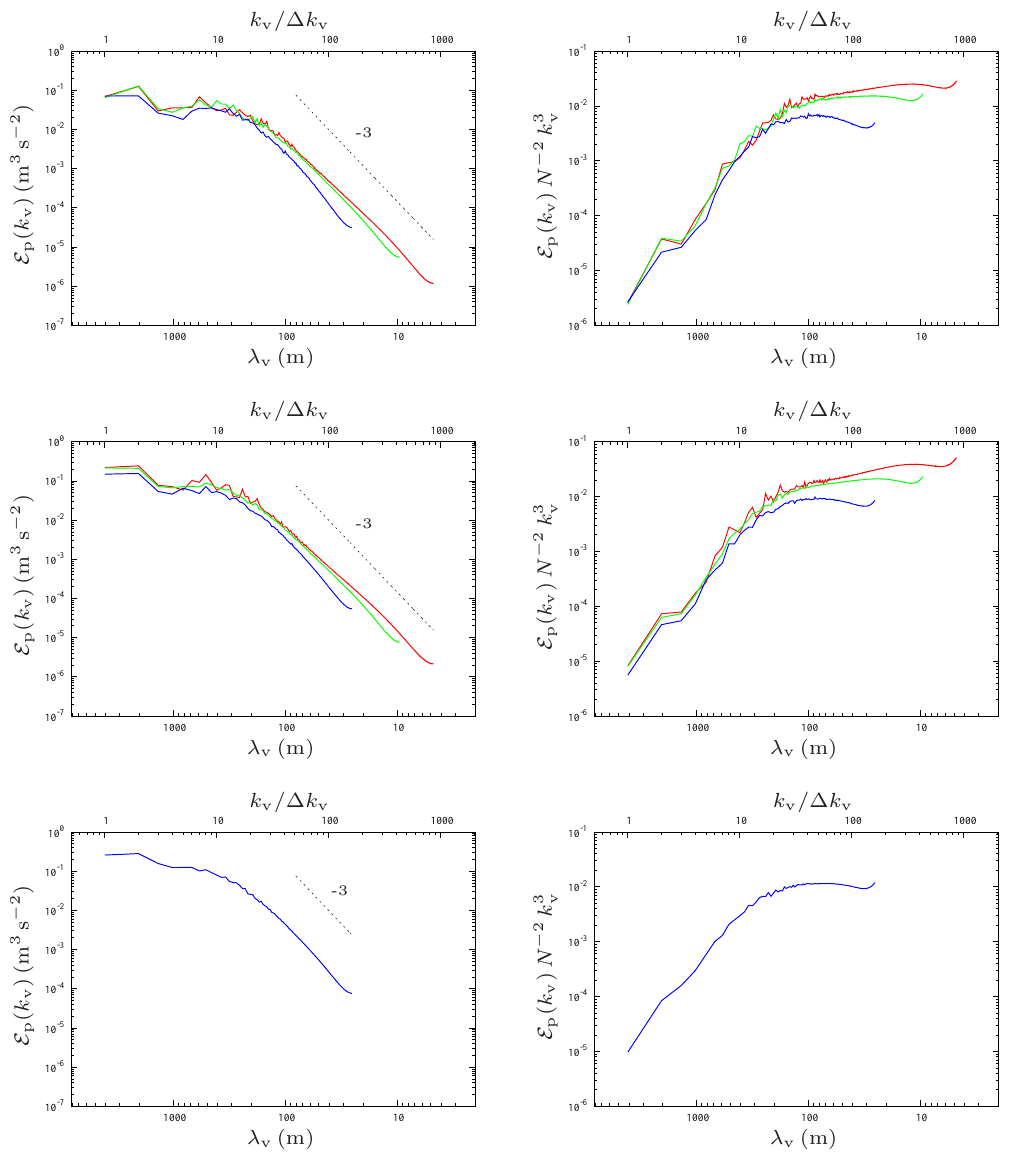
Figure 15. Vertical turbulent potential energy spectra (left panels) and compensated spectra (right panels). From top to bottom: strong forcing, moderate forcing, and weak forcing cases. Red lines: 1 = 2m; green lines: 1 = 4m; blue lines: 1 =